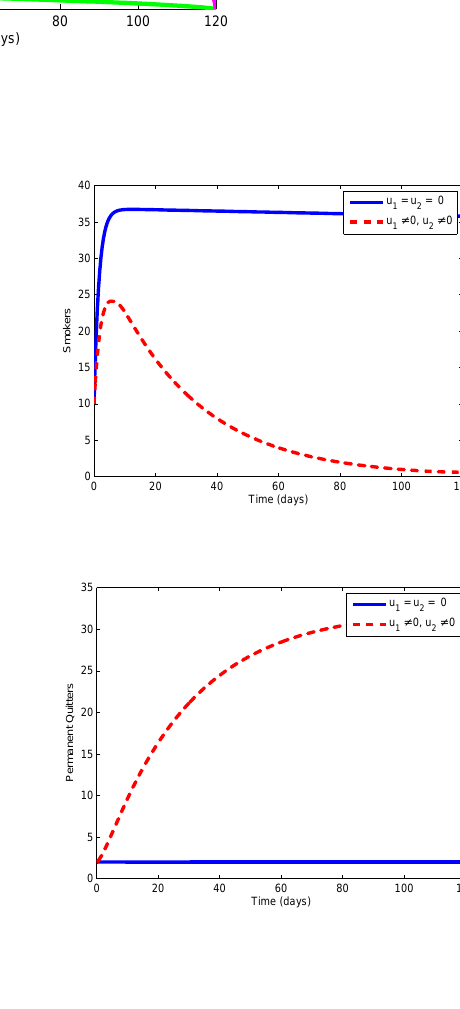
Figure 5: Reduction in smoking by the application of